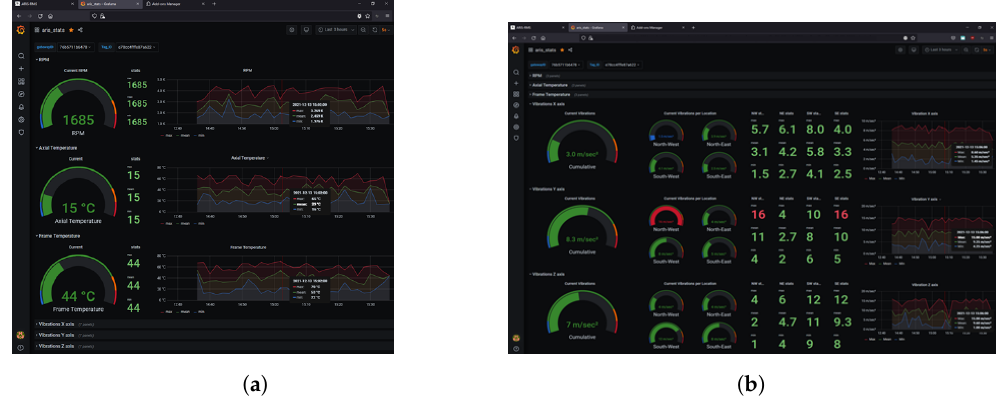
Figure 4. Stats Manager HMI. ( a ) RPM, shaft temperature and chassis temperature measurements. ( b ) Vibration measurements on the X , Y and Z axis.